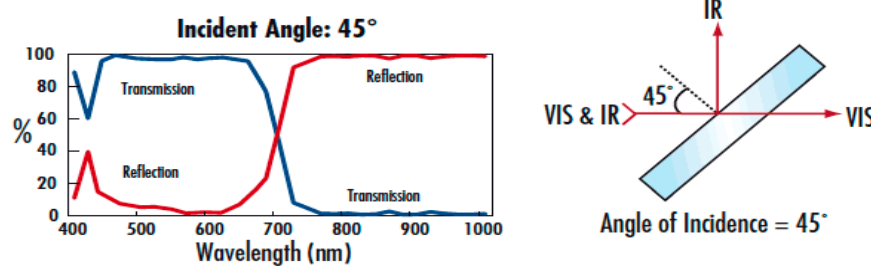
Figure 7. The transmission and reflection depend on the wavelength of plate beam splitter (PBS), which comes from Edmund Optic Inc. (Barrington, NJ, USA) [32].